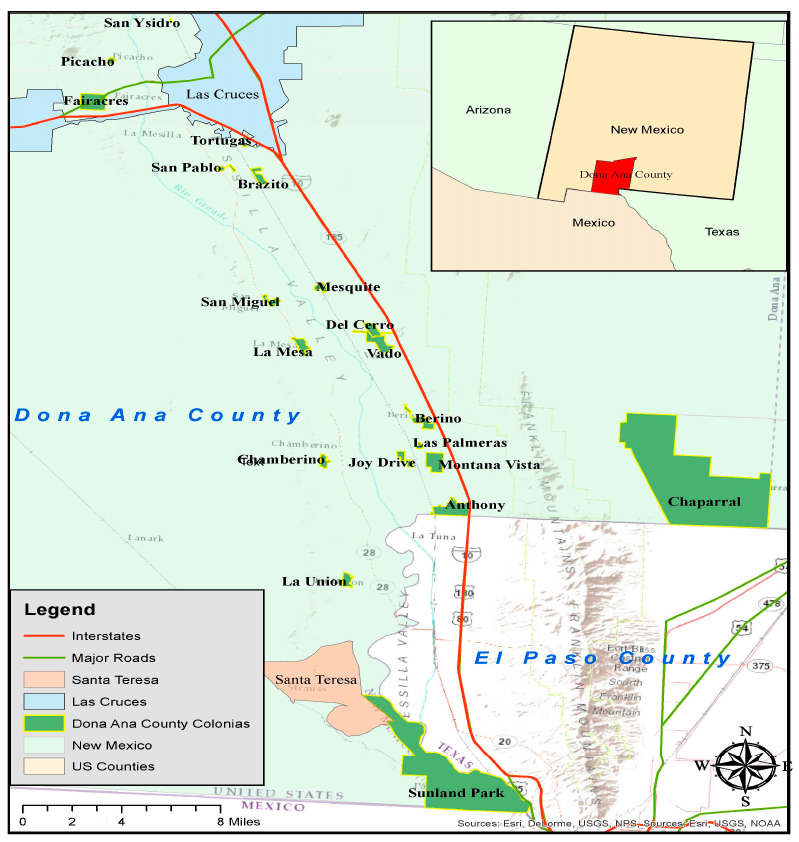
Figure 1. Map of the study area.